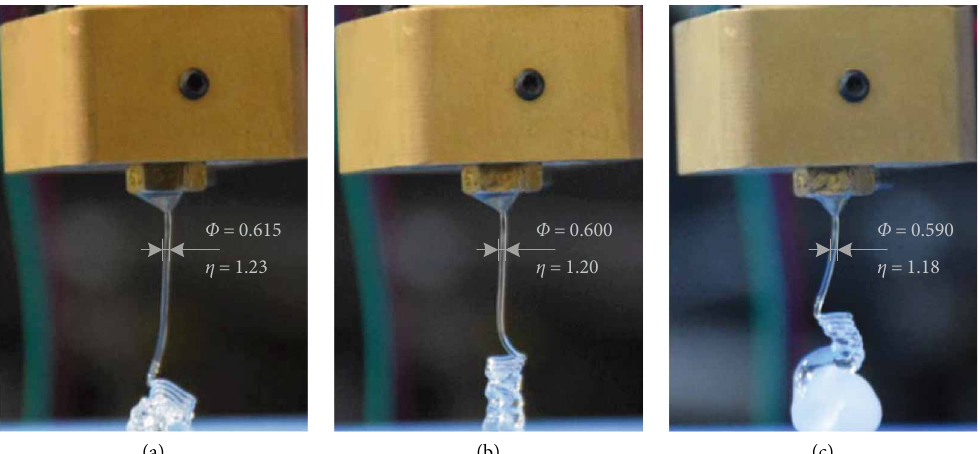
Figure 4: Different ratios of die swelling with the three speeds of the stepper motor: (a) 5.814 mm 3 s −1 ; (b) 3.681 mm 3 s −1 ; (c) 1.256 mm 3 s −1 .